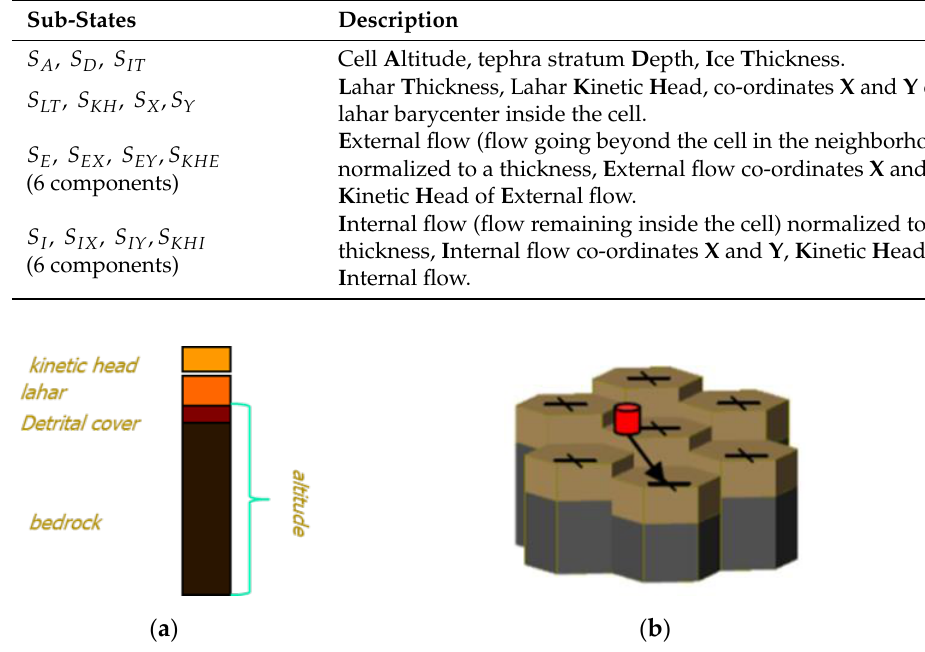
Table 2. Physical and empirical parameters. Table 1. Sub-states.